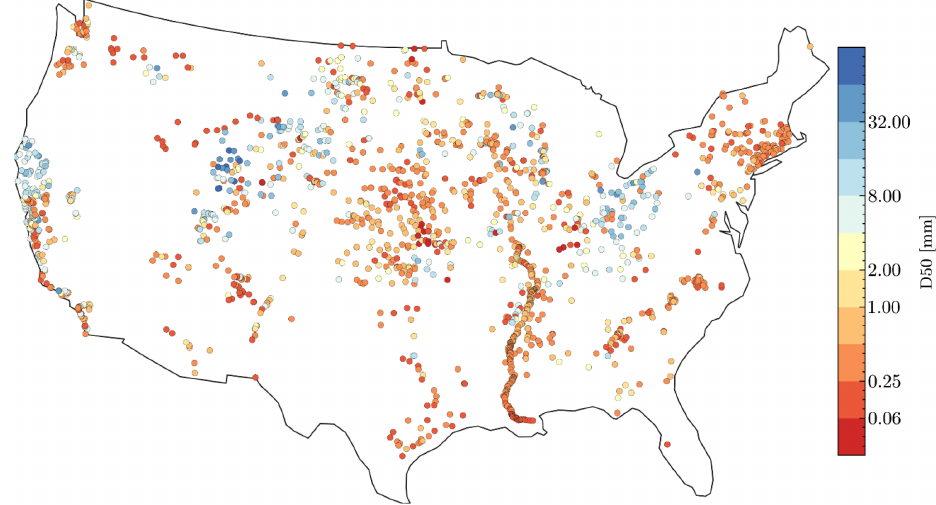
Figure 2. The 1691 flowlines with measured